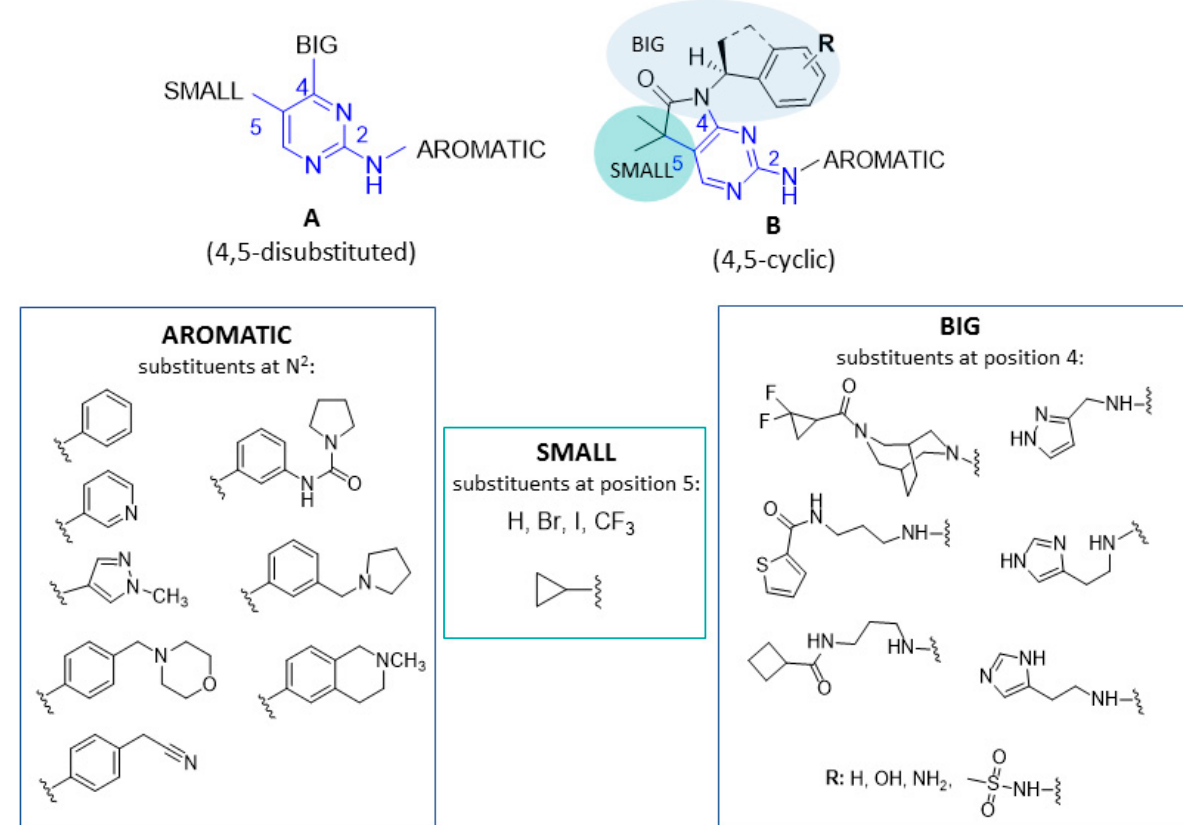
Figure 8. General structures ( A , B ) of the potent MARK4 inhibitors (IC 50 < 1 µ M) described [14–19]. The common feature of pyrimidine 2,4,5-trisubstituted ( A ) or 2-substituted-4,5-cyclic ( B ) in blue, the favorable substituents in rectangular frames.